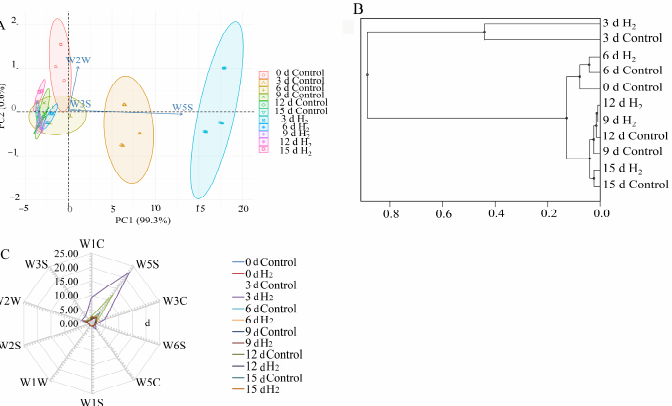
Figure 4. Principal component analysis (PCA) ( A ) and hierarchical cluster analysis (HCA) ( B ) of Lanzhou lily scales during storage based on E-nose date. ( C ): Radar fingerprint chart of the volatile compounds in Lanzhou lily scales during storage. W1C: Aromatic components, benzene; W5S: Nitrogen oxides; W3C: Ammonia, aromatic components; W6S: Hydrogen; W5C: Alkane aromatic components; W1S: Short-chain alkanes; W1W: Inorganic sulphones; W2S: Alcohols; W2W: Aromatic components, organic sulphones; W3S: Long-chain alkanes.